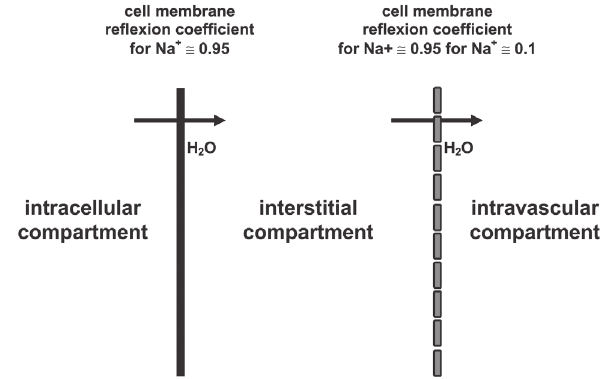
Figure 3 - Summary of physical properties of intravenously injected HS/HSD. Hypertonic Na + moves water osmotically across the cell membrane; hyperoncotic dextran or hetastarch moves water oncotically across the endothelial